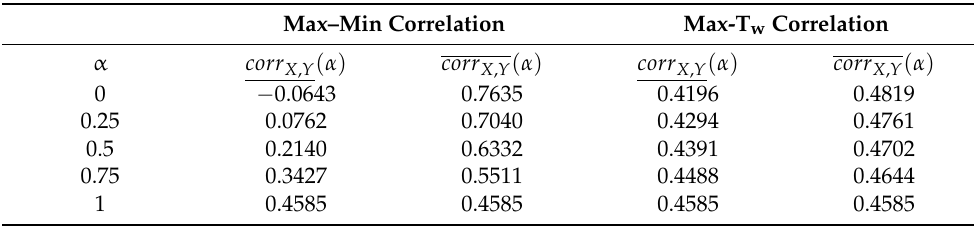
Table 7. α -cut representation of [31,34] FPPC between SER and relative reduction of poverty in EU-28 countries within the period